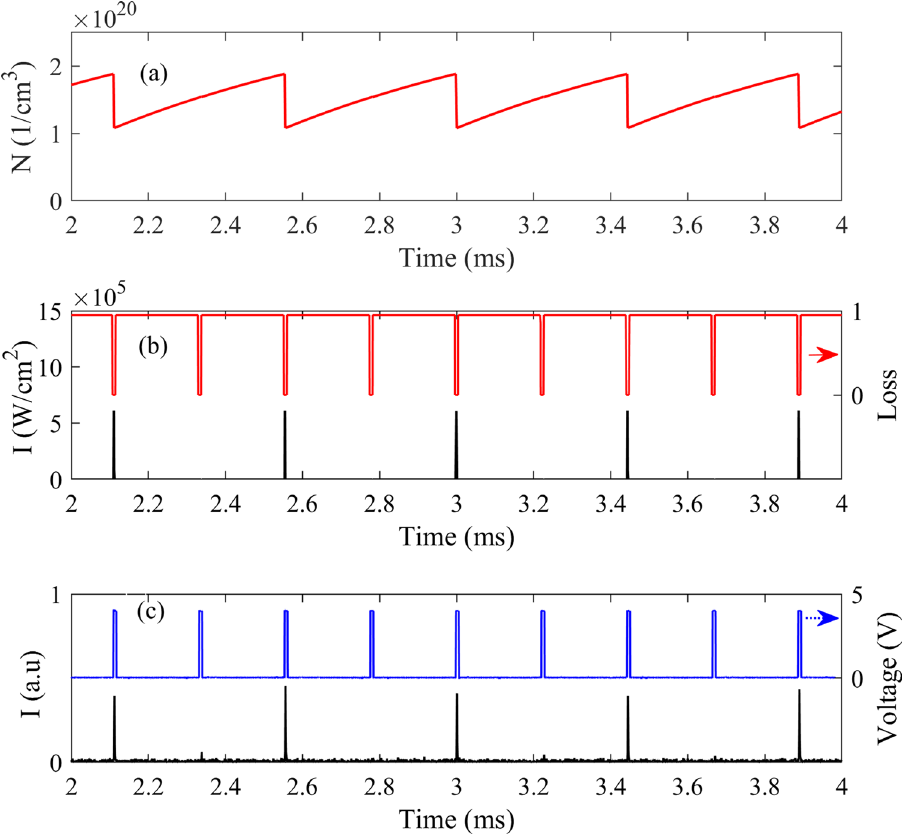
Figure 5. ( a ) The time variations of upper-laser-level population density, ( b ) the modulation loss and the calculated intra-cavity intensity, and ( c ) the measured laser output pulses in addition to a sample TTL voltage applied for driving the AO